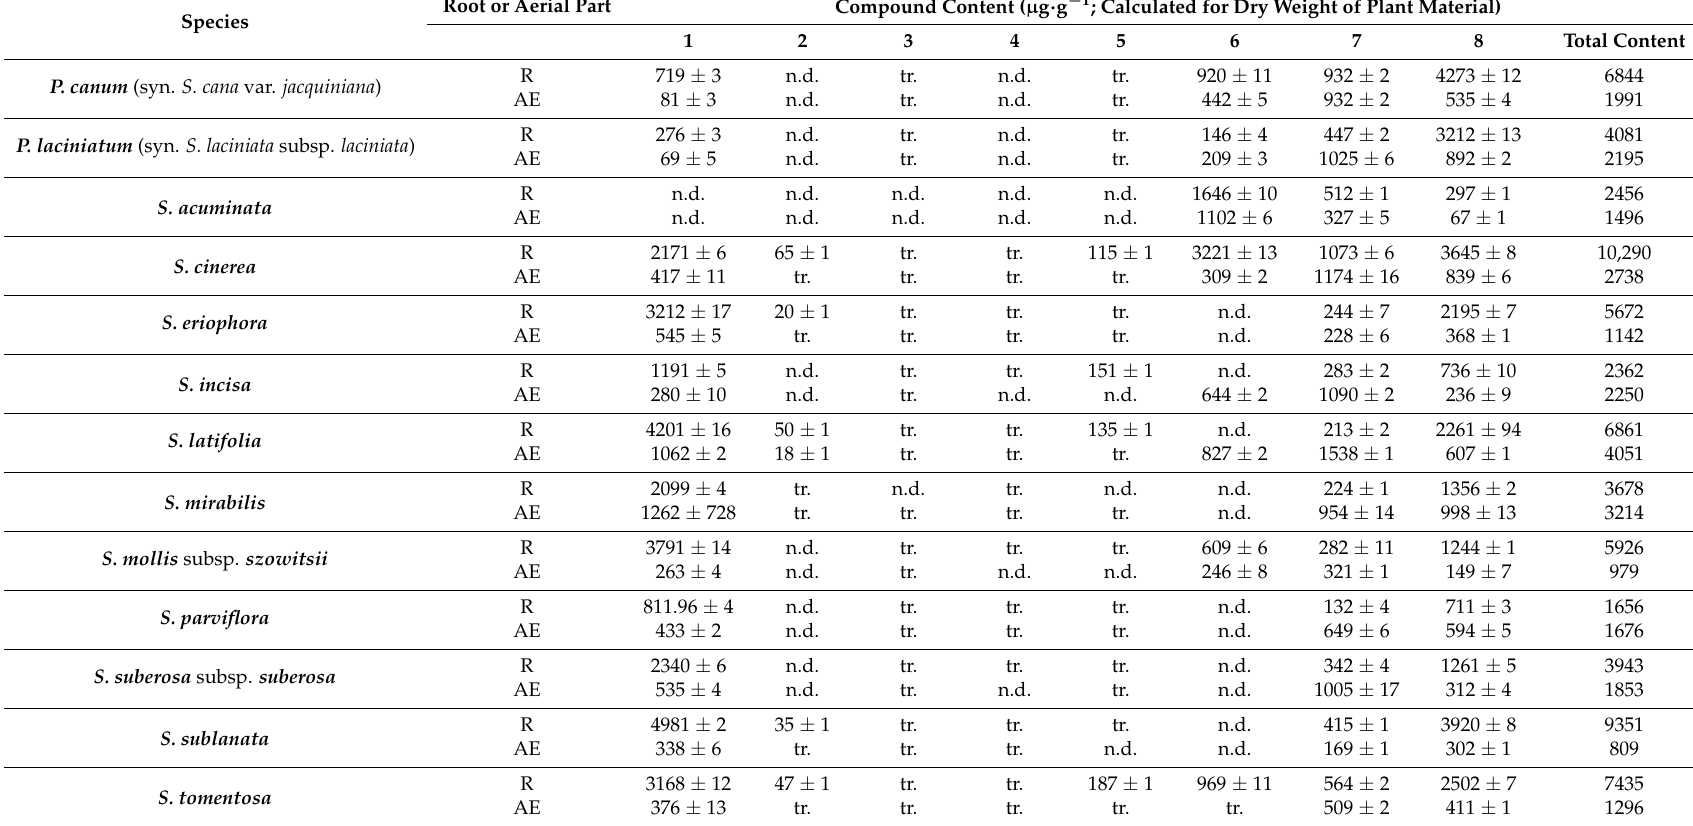
Table 2. Quantification of triterpenoids 1 – 8